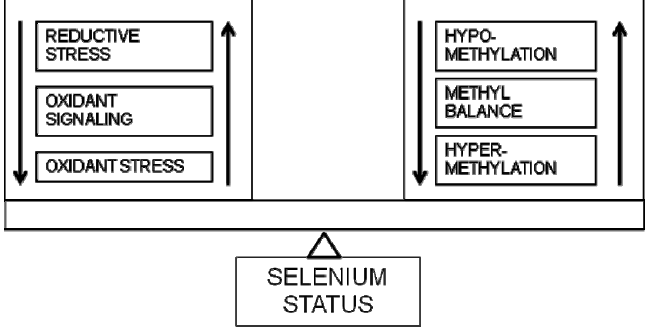
Figure 2. Selenium and redox-methylation balance. Selenium plays a pivotal role in balancing the flux between potential redox and methylation